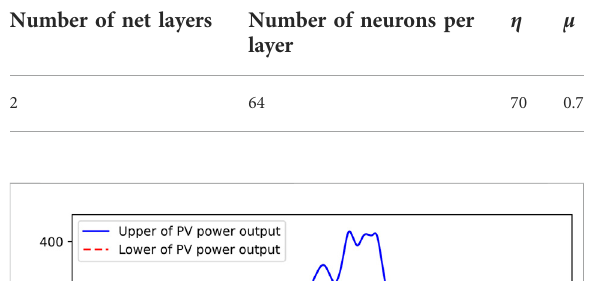
TABLE 2 LUBE parameters setting.